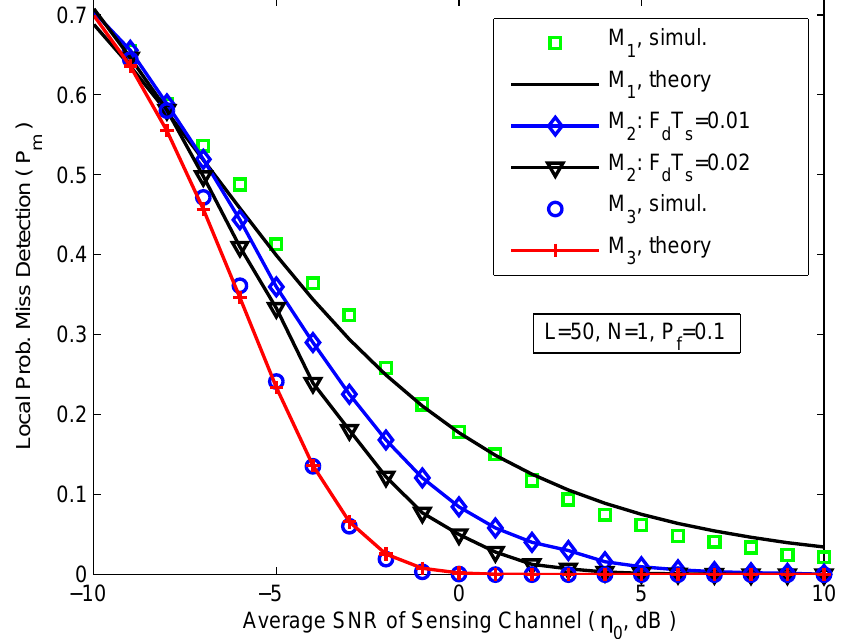
Figure 5. The local probability of misdetection for various average SNR of sensing